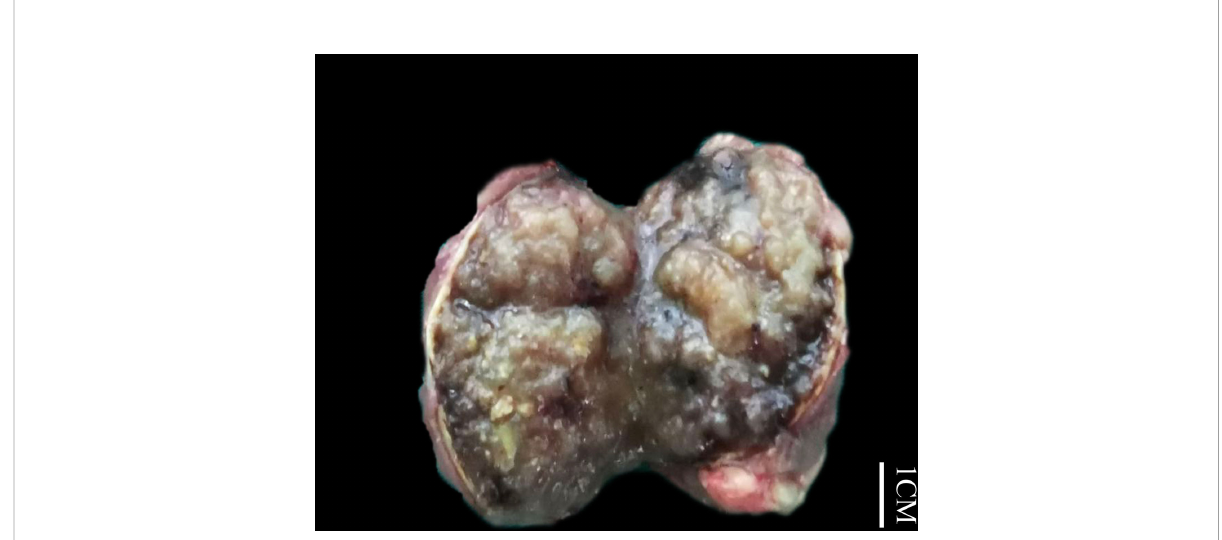
FIGURE 1 Gross examination showing an encapsulated and cystic PRNRP with a soft and friable, intracystic polypoid